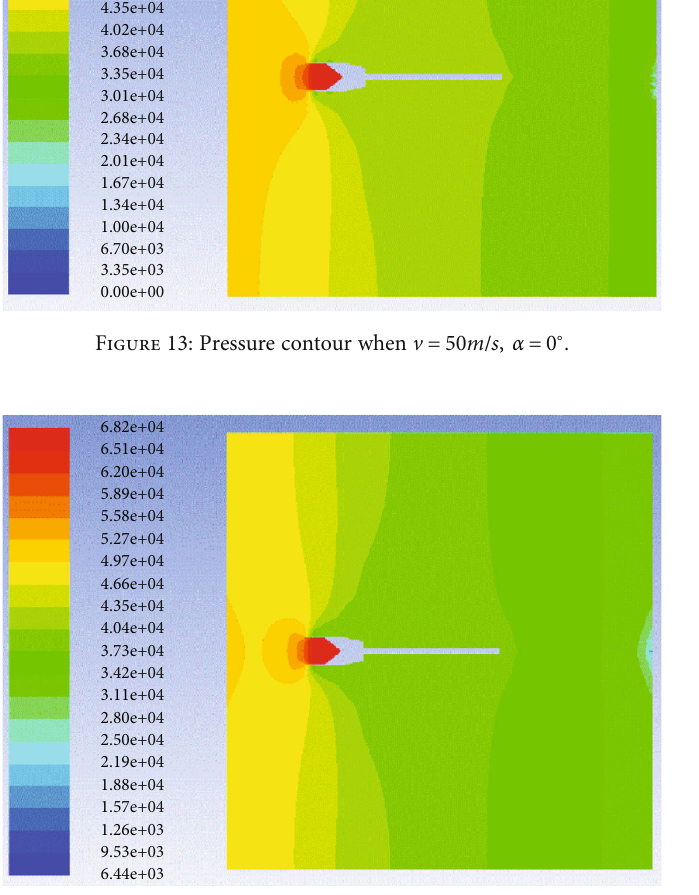
Figure 14: Pressure contour when v = 55 m / s , α = 0 ∘